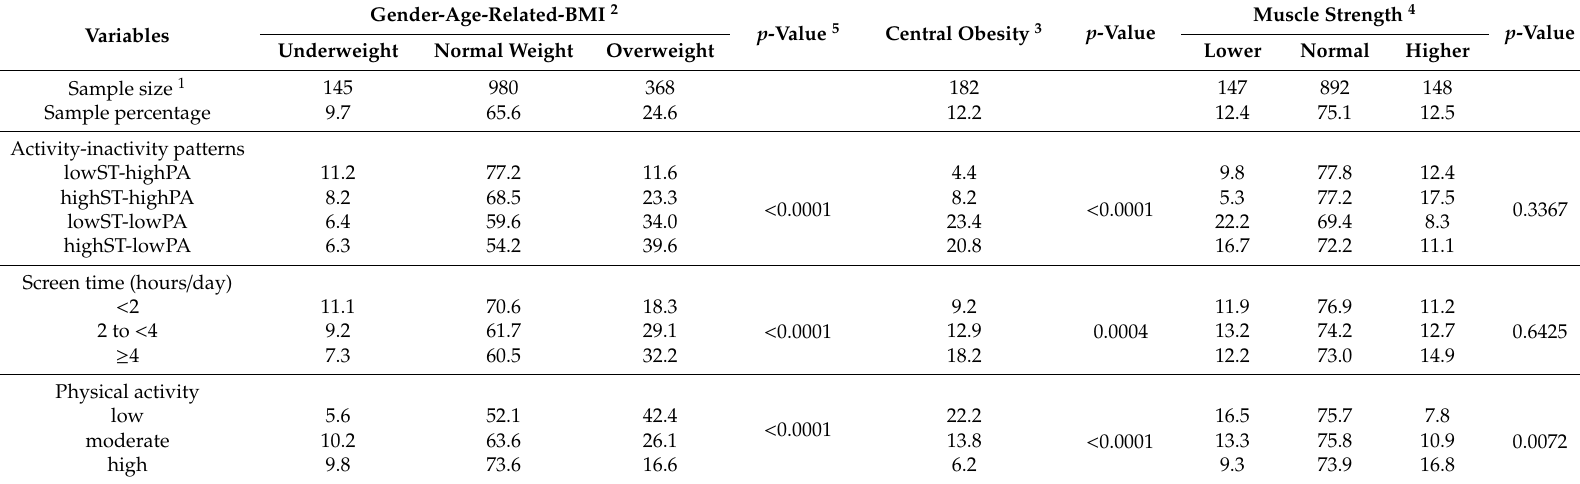
Muscle Strength 4 p -Value